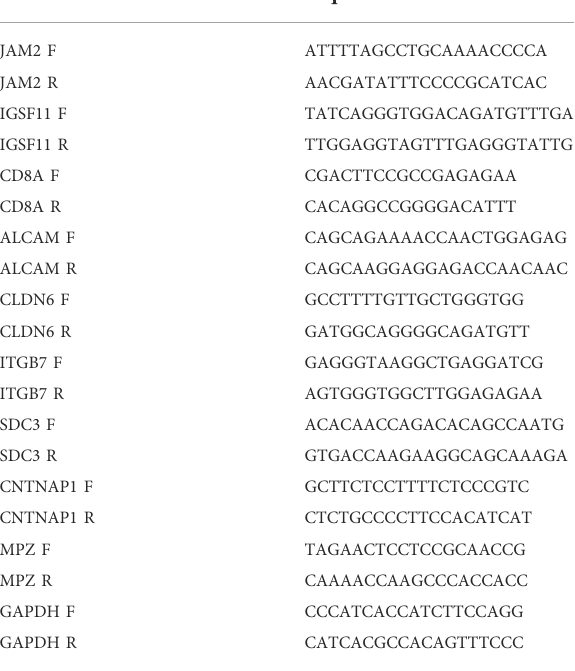
TABLE 1 Primers used for reverse transcription-quantitative